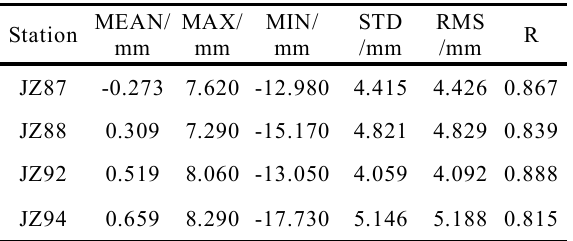
Table 4 Analysis and statistics of difference between